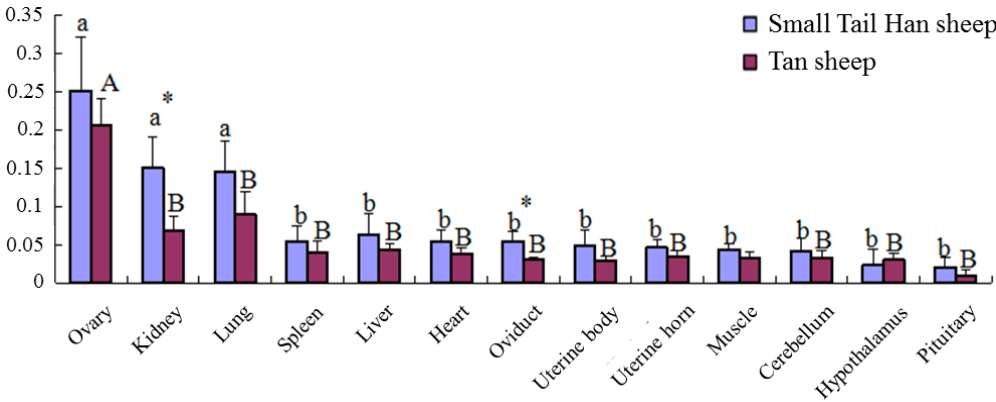
Figure 5. B4GALNT2 expression profile in STH sheep and Tan sheep. Note: Lowercase letters indicate significant differences among tissues in Small Tail Han sheep, and capital letters indicate differences among tissues in Tan sheep. Means with the same letter were not significantly different ( p < 0.05). The symbol of “*” indicates significant differences ( p < 0.05) between STH sheep and Tan sheep in same tissues.